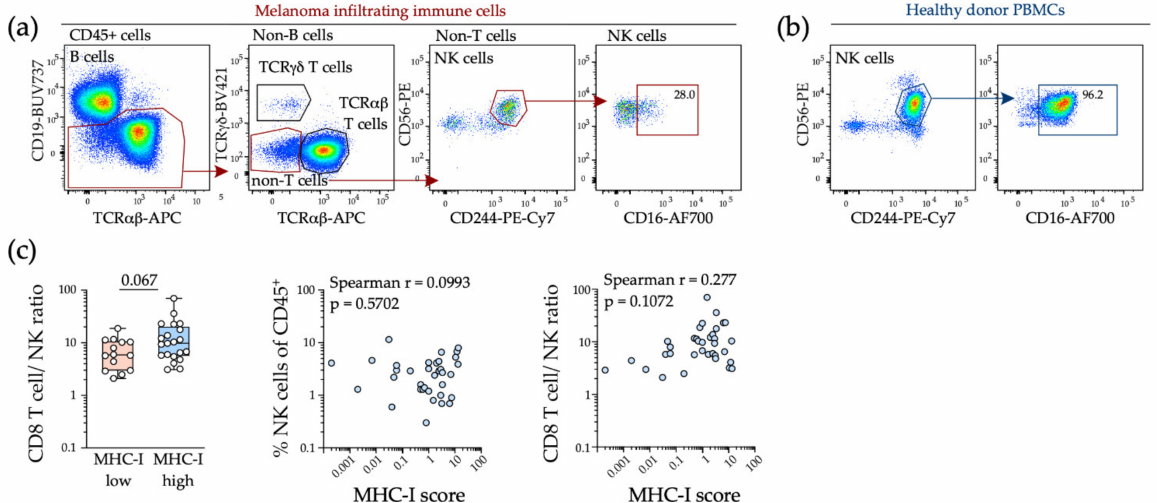
Figure 3. Abundance of tumor-infiltrating NK cells in immunotherapy-naïve melanoma patients does not correlate with tumor MHC-I expression or loss. ( a ) Identification of tumor-infiltrating NK cells by flow cytometry. Left to right, NK cells were identified as CD45 + (not shown) CD19 − , TCR αβ − TCR γδ − , CD244 + CD56 + cells. Expression of CD56, CD244 and CD16 is shown for tumor and control blood ( b ). ( c ) Lack of correlation between melanoma MHC-I expression and NK cell infiltration. Left to right, ratio of (CD45RO + TCR αβ + CD8 + ) TILs to NK cells in MHC-I high (MHC-I score ≥ 1.0) and MHC-I low melanoma biopsies (MHC-I score <1.0); correlation of NK cell frequency and melanoma MHC-I expression score; correlation of CD8/NK cell ratio and melanoma MHC-I expression score. For the details on the study cohort ( n = 36) and the calculation of the tumor MHC-I score, see reference